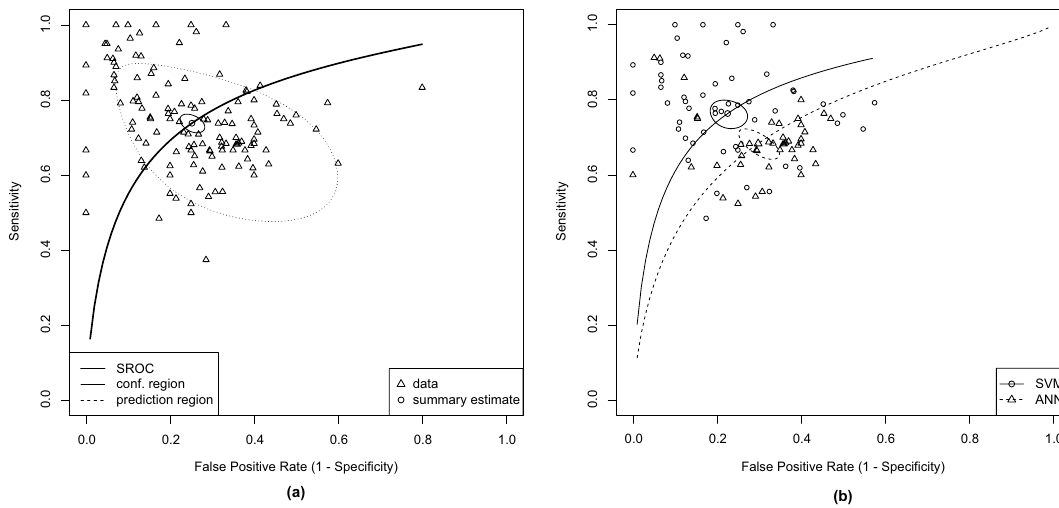
Figure 5. SROC curves of all the included studies with summary estimate (a) and the studies using SVM and ANN with their summary estimates and confidence region (b) . Created with R Statistics 125 version 4.1.1 using the package mada 126 version